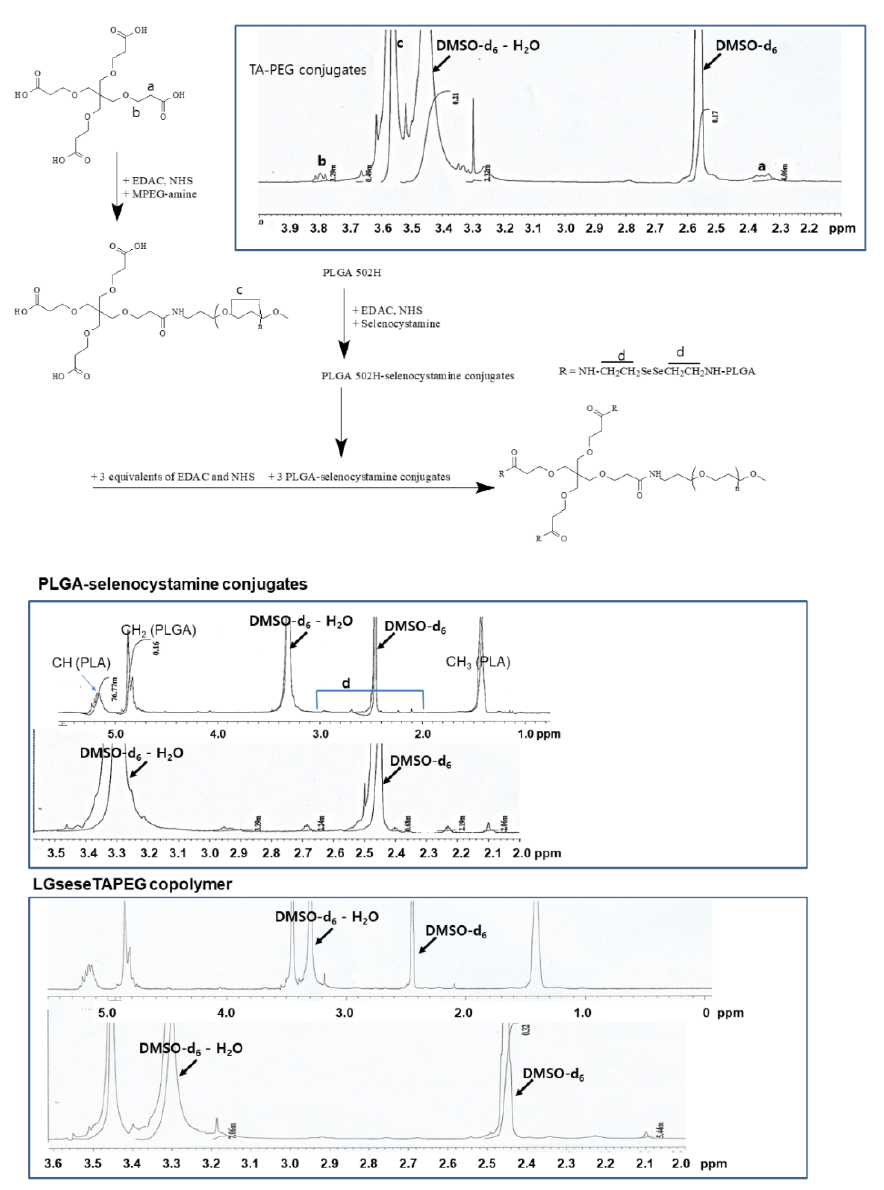
Figure 1. Synthesis scheme and 1 H-NMR spectra of LGseseTAPEG copolymer.